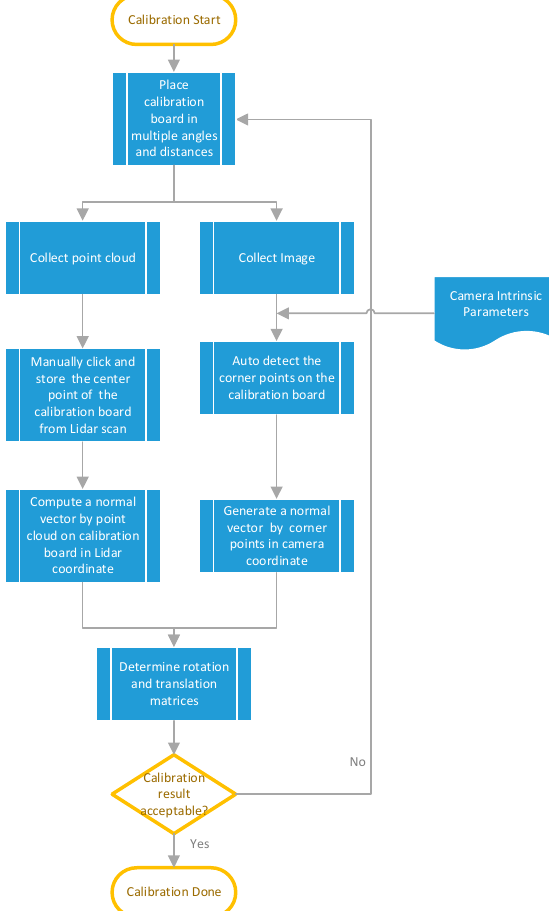
Figure 11. Flowchart of extrinsic calibration between camera and Lidar sensors.